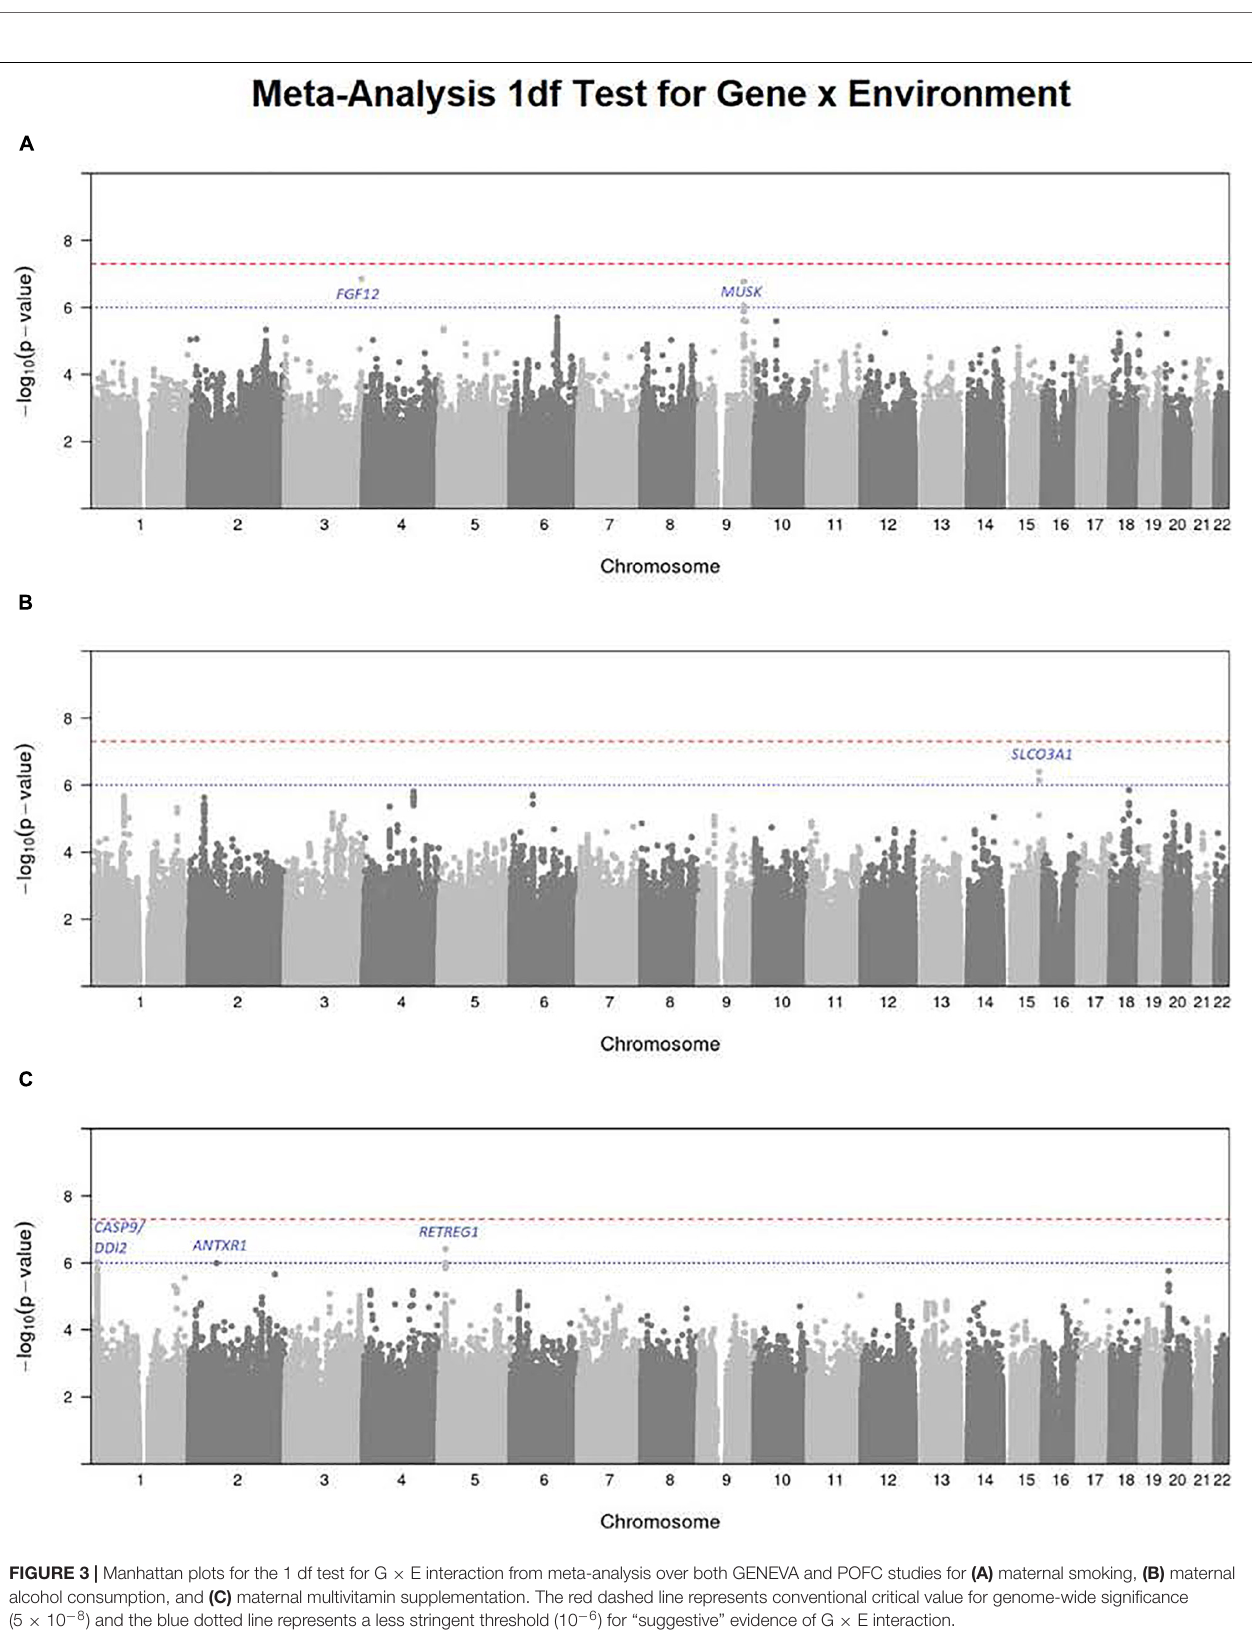
Frontiers in Cell and Developmental Biology |